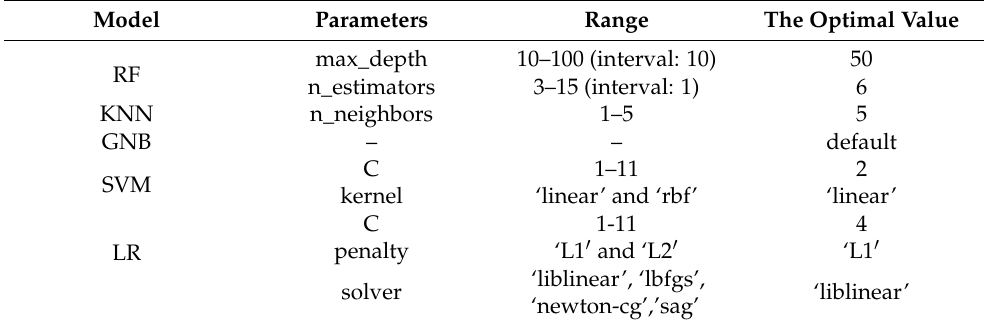
Table A1. Description of tuning parameters in the five machine learning algorithms with 10-fold cross